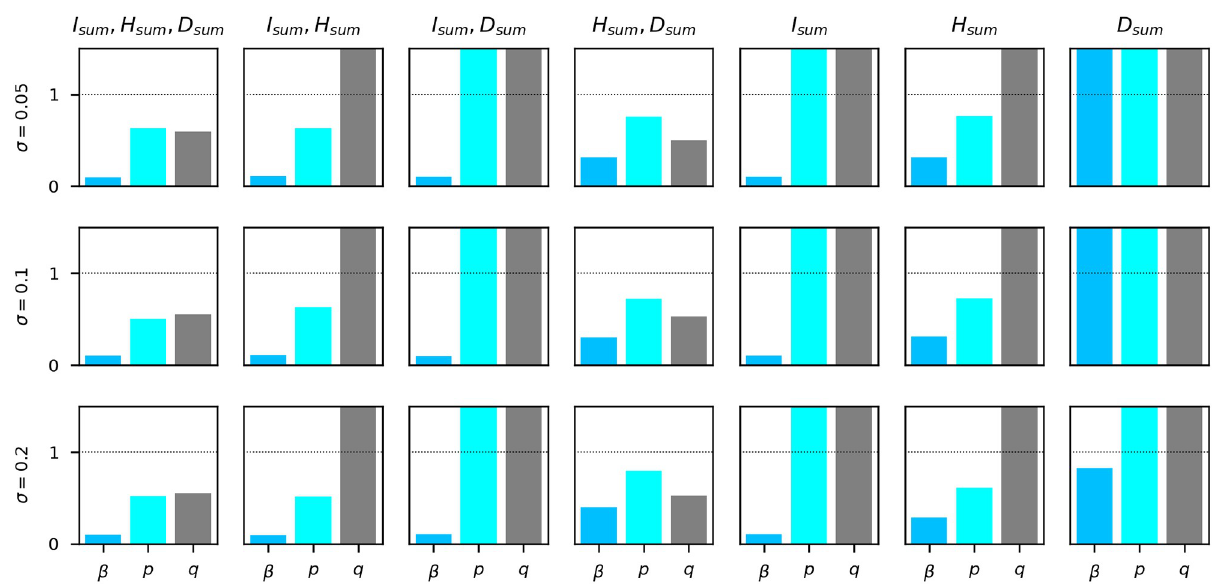
Fig 9. Average Relative Error (ARE) of ( β , p , q ) in different observable settings. Each row corresponds to a standard deviation level of random noise multiplied to the observables. Each column represents an observable setting. When ( I threshold 1. Therefore, our model is robust to noise in the NYC dataset. In the rest of of the missing observable cases, our model would not be robust to perturbations, which is consistent with the structural identifiability result.